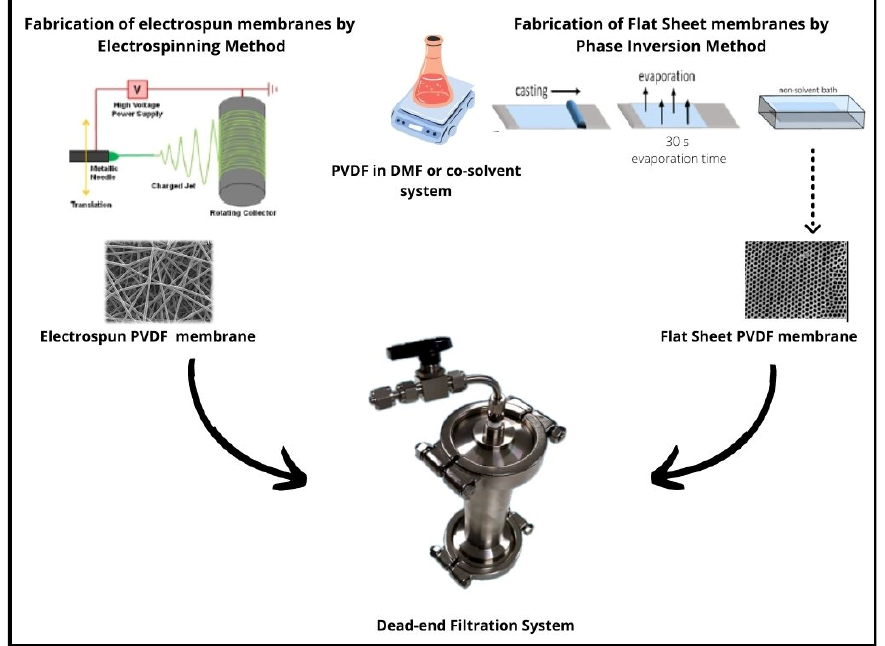
Figure 1. Schematic setup of electrospinning and phase inversion fabrication methods of PVDF Electrospun nanofibrous and flat-sheet